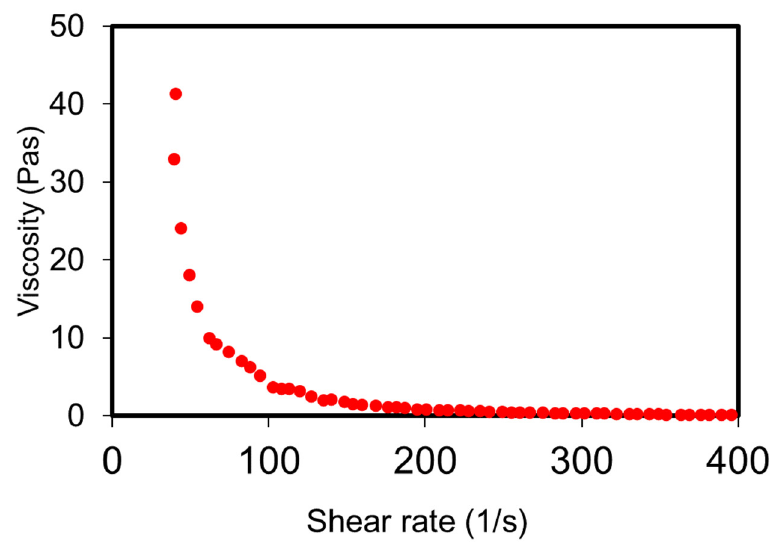
Figure 2. Dynamic viscosity of the pramlintide depot gel formulation in shear rates 0.1 1/s–400 1/s. The data confirm the shear thinning properties of the formulation.